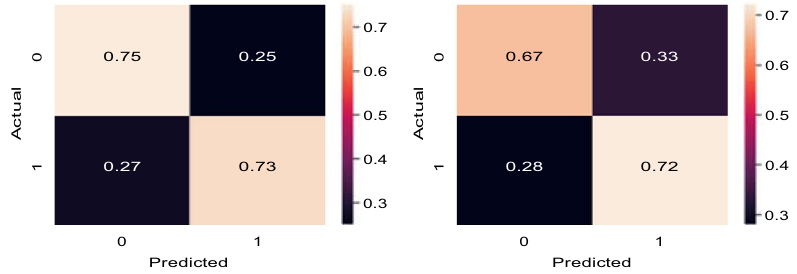
Figure 10. Dataset 2: Confusion matrices for the best results of AutoThorax -Net (left) and CheXNet